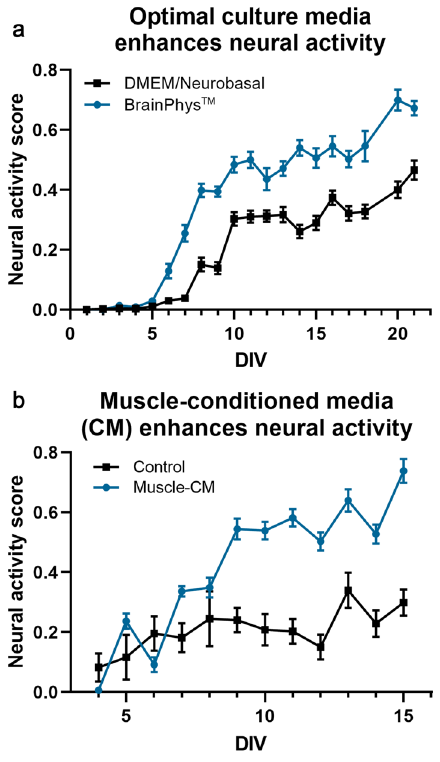
Figure 3. Enhancement of neural network ontogeny is easily quantified using neural activity score. ( a ) BrainPhys-based culture media results in clear enhancement of neural activity compared to traditional DMEM/ Neurobasal-based media, and this enhancement is quantifiable via NAS (p < 0.0001, two-way repeated measures ANOVA, n = 24/group). ( b ) Muscle-conditioned media treatment results in similar enhancement of neural activity (p < 0.0001, two-way repeated measures ANOVA, n =